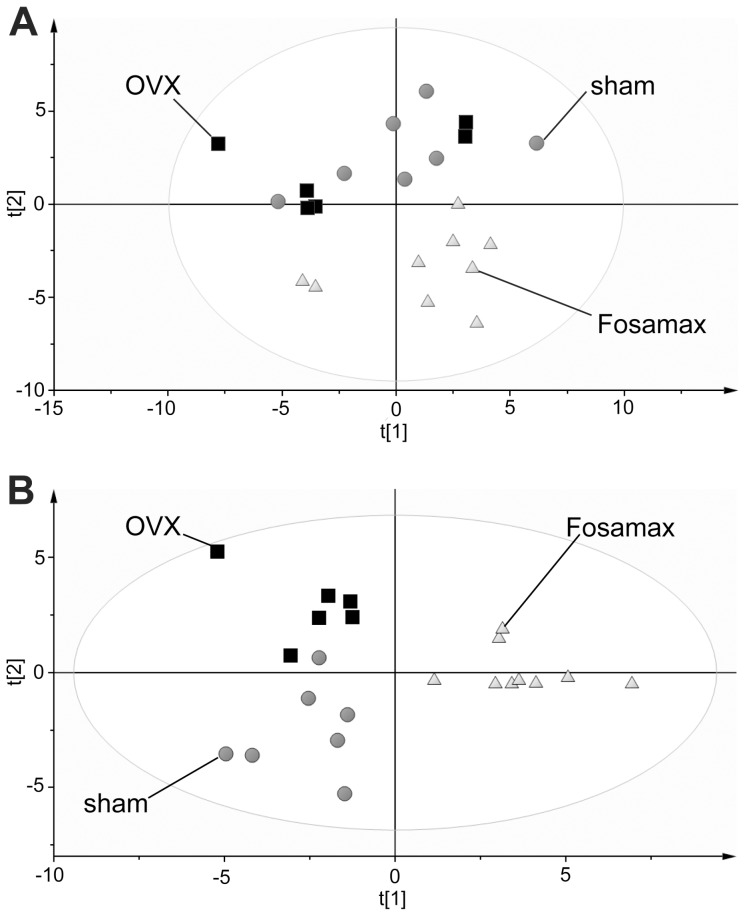
Comparison of metabolic composition of serum.(A) PCA (R2X = 0.642, Q2 = 0.178) and (B) PLS-DA (R2Y = 0.915, Q2 = 0.700) models of serum metabolite concentrations of sham C57BL/6 female mice compared with ovariectomized mice with and without Fosamax treatment for 23 weeks. Permutation testing revealed that the model was valid, with all values of the permuted R2Y and Q2 data being significantly less than the original model (p<0.001).